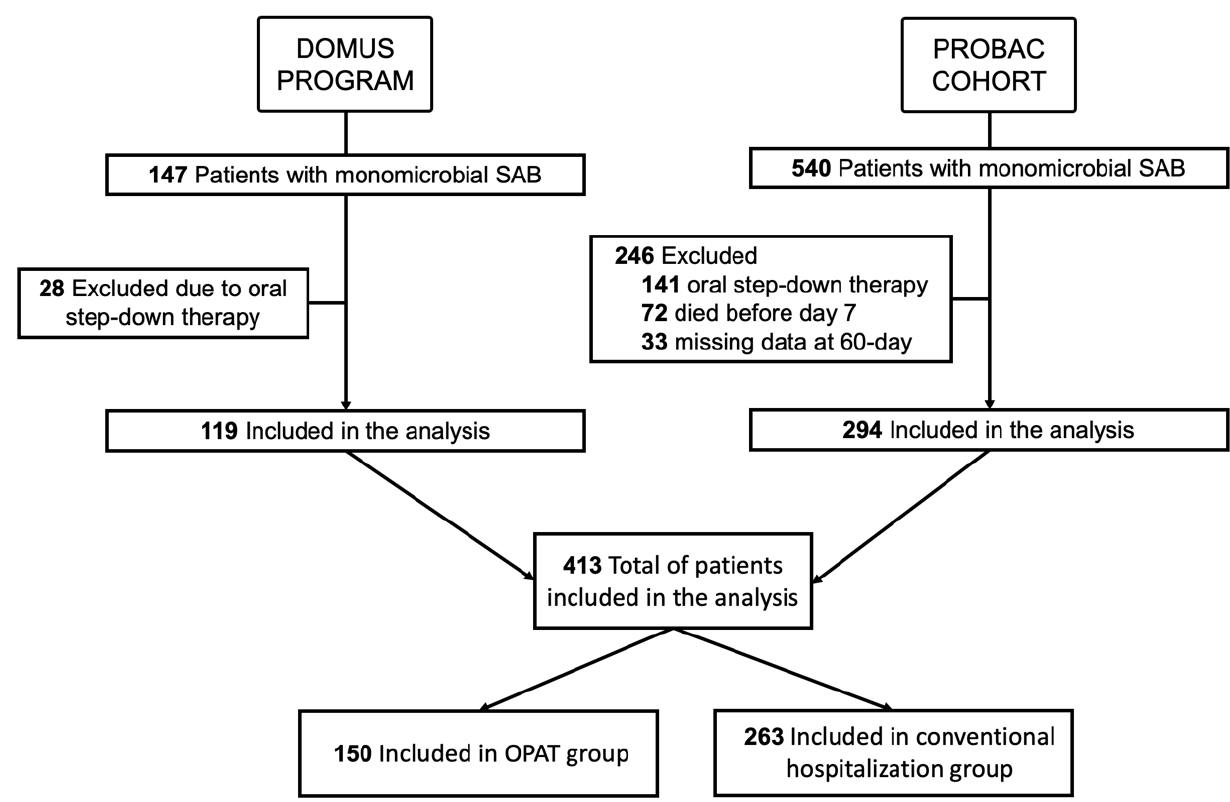
Figure 1. Flowchart of study.